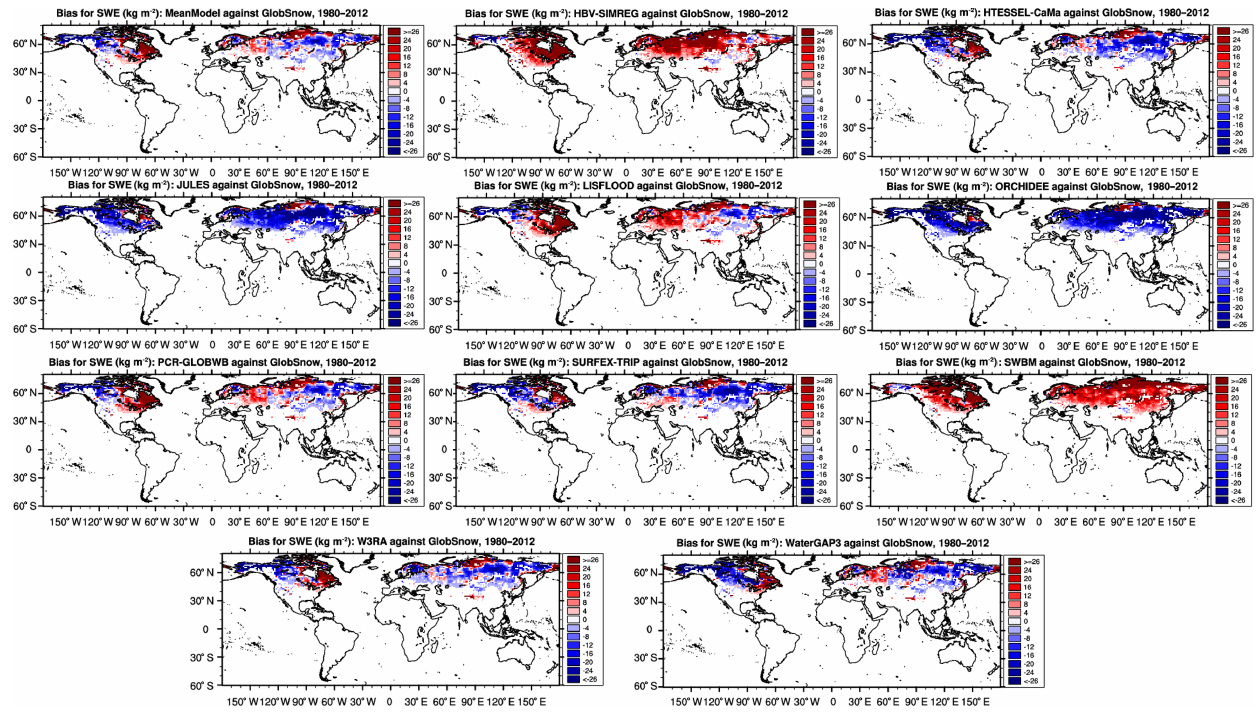
Figure 6. Bias in kgm − 2 between GlobSnow and the model results. The top left figure shows the ensemble mean. Reds denote a positive bias, blues a negative bias.